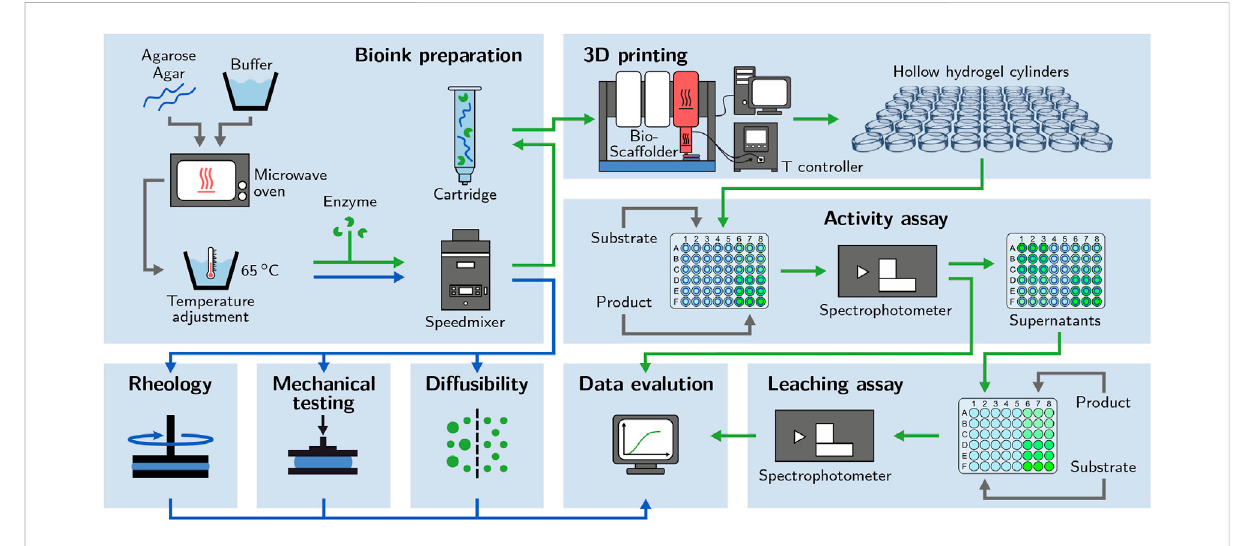
FIGURE 1 Schematic of the applied work fl ow. Bioinks based on different concentrations of low-melt agarose and agar are prepared. Enzyme-loaded hydrogel cylinders are printed to perform activity assays. The supernatants are used for leaching assays. Enzyme-free bioinks and hydrogels are examined with rheological analysis, mechanical testing and diffusibility